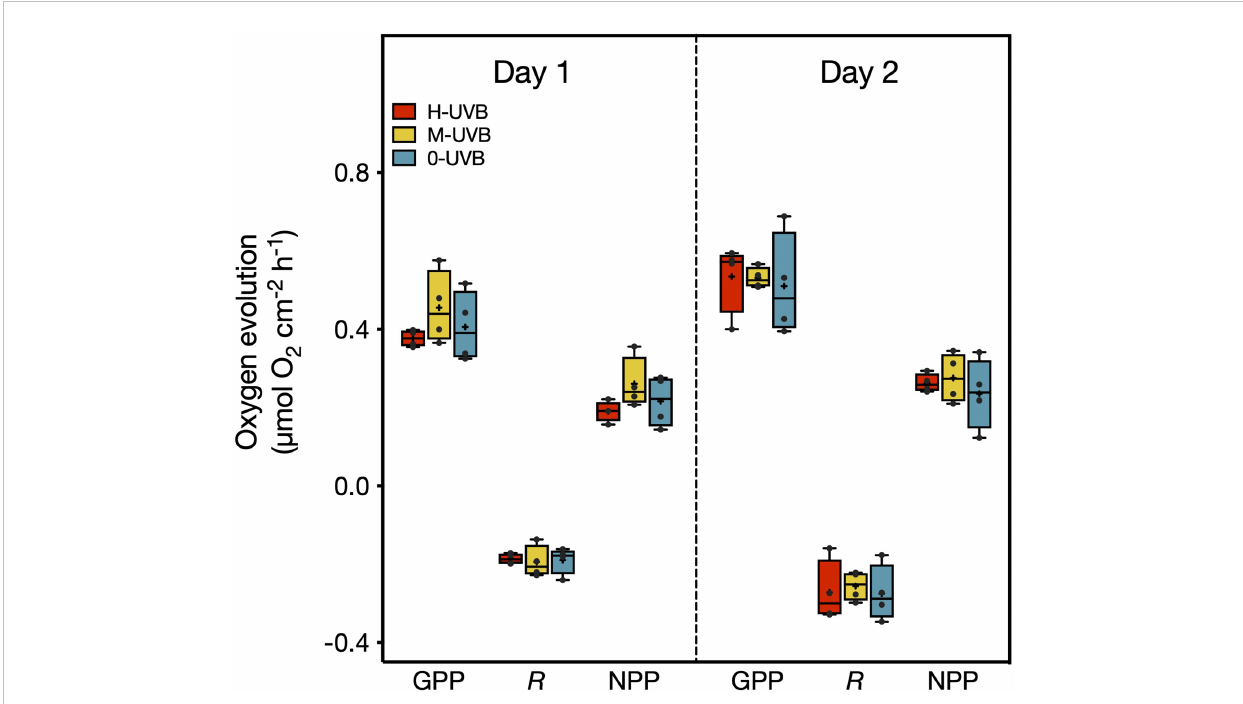
FIGURE 2 Oxygen evolution/consumption (µmol O 2 cm -2 h -1 ) measured during the incubations as part of the Stylophora pistillata experiment on 6 th (Day 1) and 7 th October 2016 (Day 2). Displayed are the gross primary production (GPP), respiration ( R ), and net primary production (NPP). Samples were incubated in either full UVB (red), medium UVB (yellow), or under UVB-removal (blue) conditions. Horizontal lines inside the boxplots indicate median values, and crosses the means. Black dots represent individual data points. One-way ANOVAs and subsequent Tukey ’ s post hoc tests identi fi ed no signi fi cant differences ( p < 0.05) between treatments for any of the three parameters on either